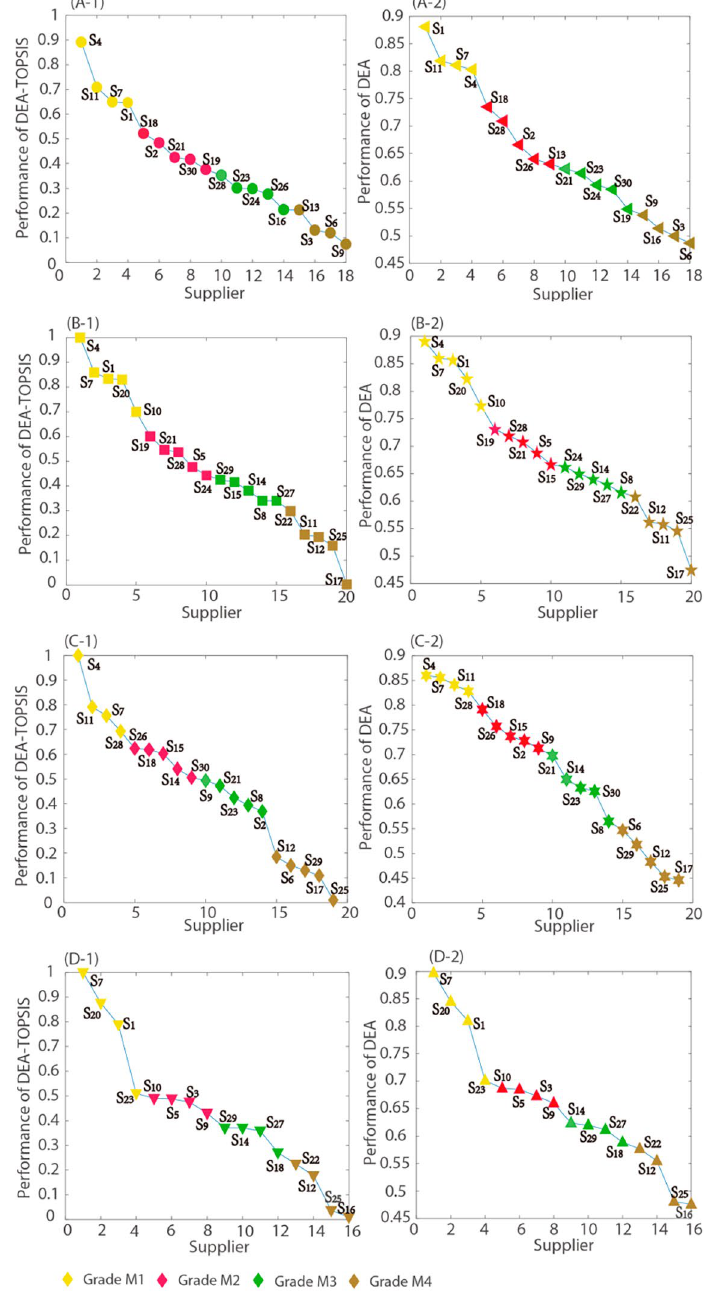
Figure 6. Supplier rankings and categories for components A-D under DEA-TOPSIS and DEA approaches Note: A – intake air pressure sensor; B – oil injection nozzle; C – oxygen sensor; D –